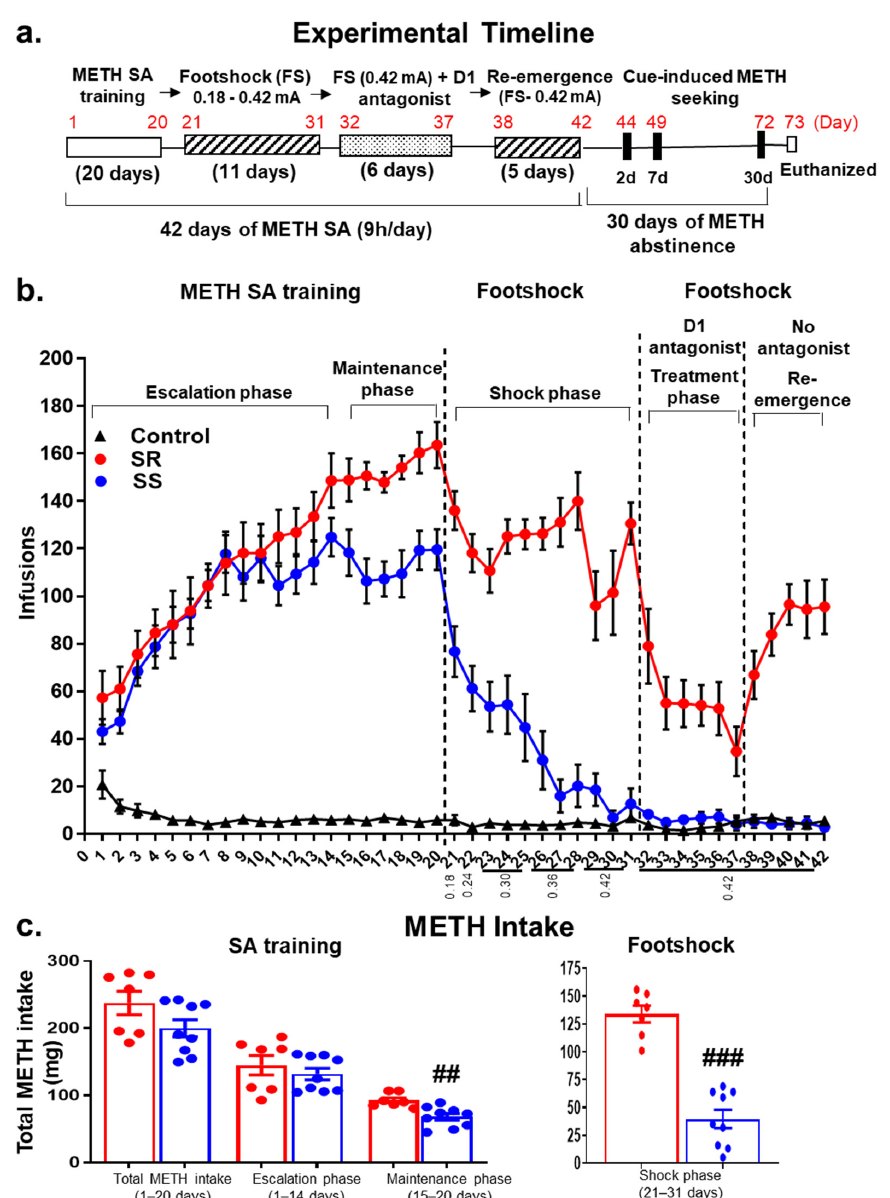
Figure 1. ( a ) Experimental timeline for METH SA, contingent footshocks, and administration of the D1 antagonist, SCH23390. ( b ) Patterns of METH (n = 16) or saline (CT, n = 8) SA in male Sprague–Dawley rats. Infusion patterns during 20 days of SA training include escalation (1–14 days), maintenance (15–20 days) and footshock (21–31 days) phases. During the shock phase, current intensity was increased gradually from 0.18 to 0.42 mA over 11 days. METH SA rats were segregated into two distinct phenotypes based on their response to contingent footshocks. The shock-resistant rats (SR, n = 7) showed less than 20% decreases in the average number of METH infusions from pre-shock levels despite the footshocks. The shock-sensitive rats (SS, n = 9) significantly reduced their METH intake. On the days of SCH23390 administration, rats were given the drug 30 min prior to the METH SA sessions. SCH23390 reduced the number of METH infusions ( p < 0.0001) in both phenotypes. After stopping SCH23390 administration, SR, but not SS, rats returned to compulsive METH-taking behaviors. Data represent the number of daily infusions during 9 h of access to METH or saline (0.1 mg/kg/infusion). ( c ) Total METH intake by SR (n = 7) and SS (n = 9) rats during the 20 days of METH SA training followed by footshock (0.18–0.42 mA). The values represent means ± SEM. Key to statistics: ##, ### = p < 0.01, 0.001, comparison between SR and SS METH